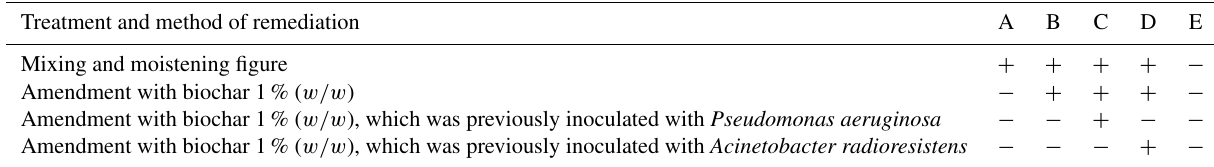
Table 1. Treatments of oil-polluted soil used in the study. Treatment and method of remediation A B C D E Mixing and moistening figure + + + + − Amendment with biochar 1% ( w/w ) − + + + − Amendment with biochar 1% ( w/w ), which was previously inoculated with Pseudomonas aeruginosa − − + − − Amendment with biochar 1% ( w/w ), which was previously inoculated with Acinetobacter